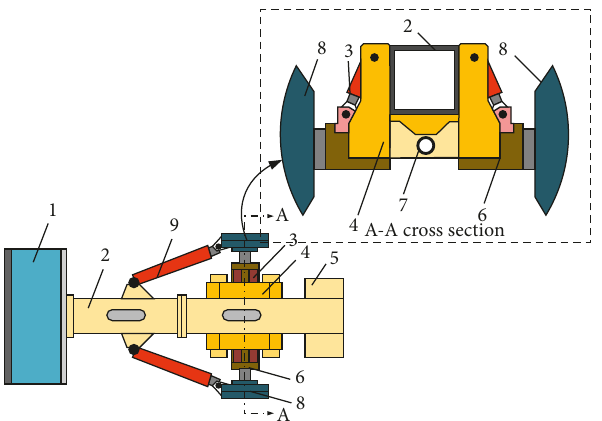
Figure 1: Horizontal single-support structure model of the shield machine. 1, cutter head; 2, main beam; 3, torque cylinder; 4, saddle frame; 5, rear leg; 6, horizontal supporting cylinder; 7, cross pin; 8, gripper shoe; 9, propulsion